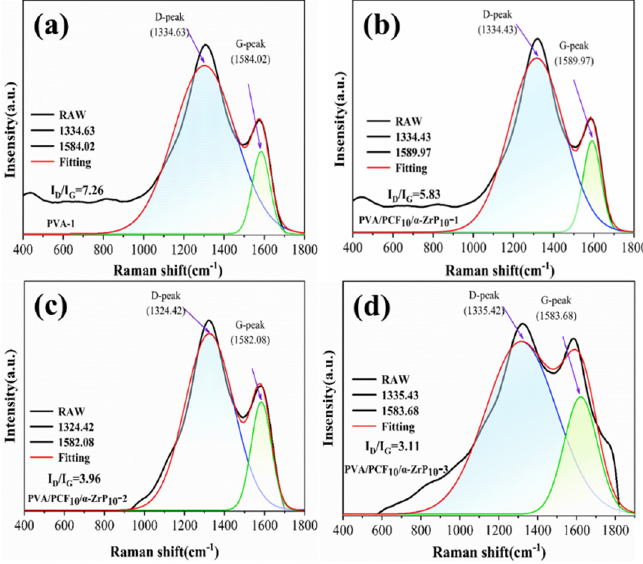
Figure 14. Raman spectra of the residues: ( a ) PVA, ( b ) PVA/PCF 10 / α -ZrP 10 -1, ( c ) PVA/PCF 10 / α -ZrP 10 -2, and ( d ) PVA/PCF 10 / α -ZrP 10 -3.